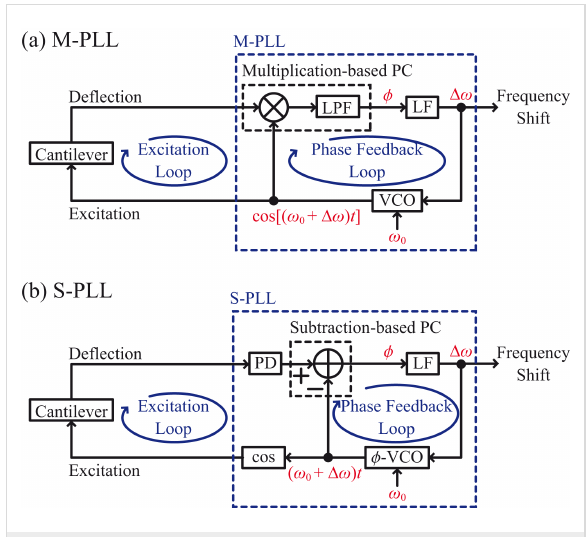
Figure 1: Basic designs of (a) M-PLL and (b) S-PLL